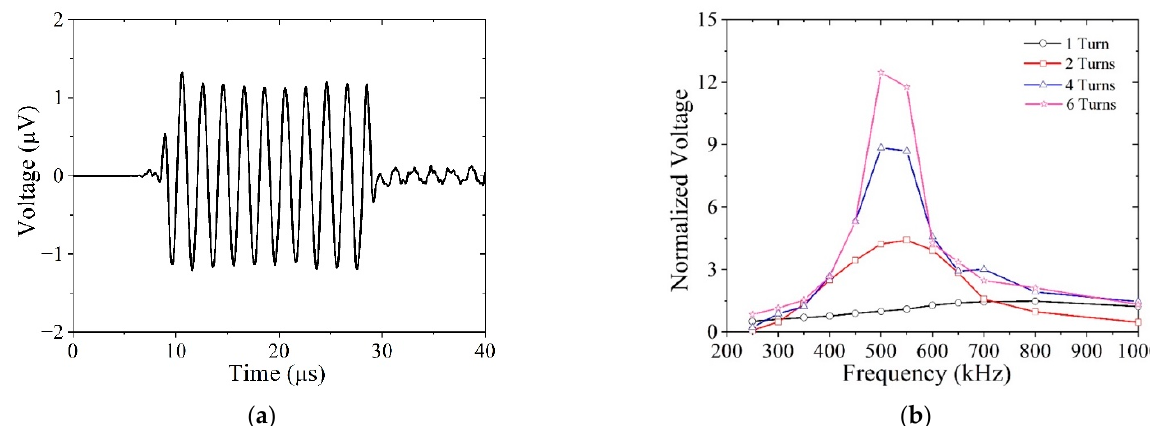
Figure 16. Reception bandwidth of SH wave MSTs with different numbers of coils: ( a ) A-scan signal showing the received signal for 500 kHz and a 1-turn coil (reference case); ( b ) normalized amplitudes of SH0 waves at different frequencies received by different coils.